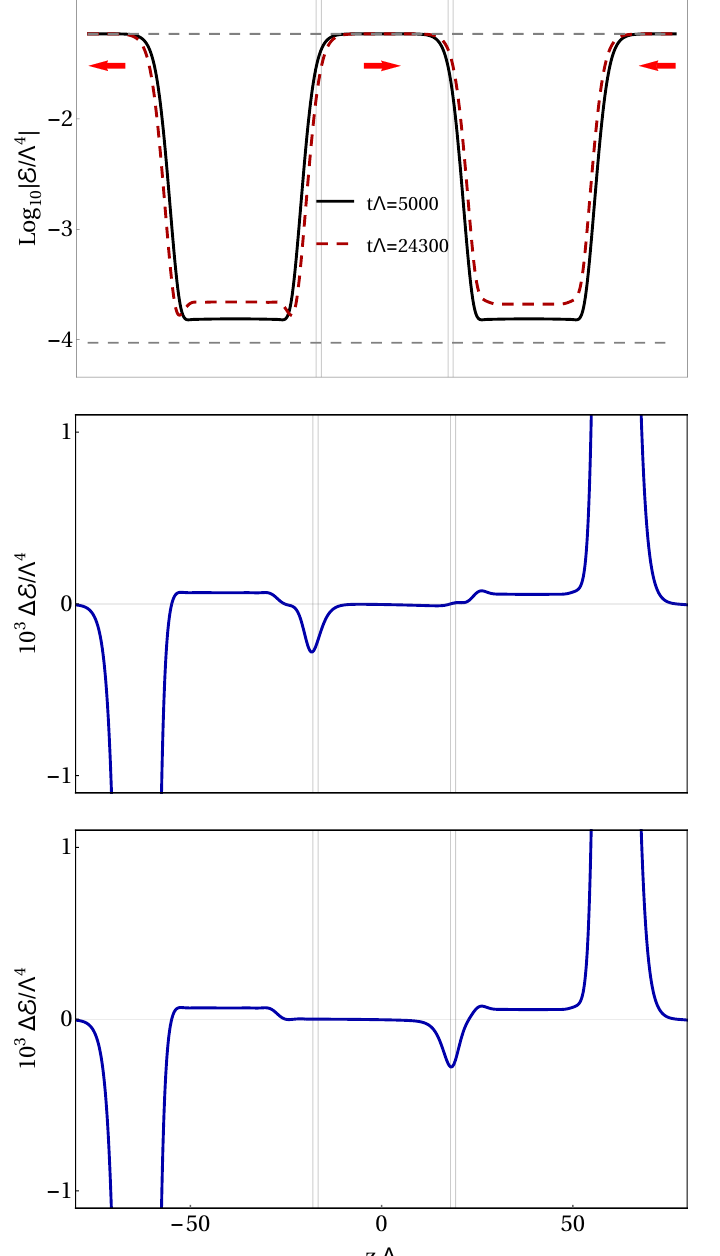
Figure 20 . (Top) Snapshots of the energy density at two very late times for the simulation of (cid:12)gure 16(right). The top and bottom dashed, grey, horizontal lines correspond to E high and E low , respectively. The arrows indicate the direction of motion of each domain. (Middle) Di(cid:11)erence between the energy densities in (top), E ( t (cid:3) = 24300) (cid:0) E ( t (cid:3) = 5000), having shifted the red, dashed curve to the left by an amount (cid:1) z (cid:0) (cid:1) ‘= 2 (see main text). (Bottom) Same di(cid:11)erence between the two energy densities in (top) but now having shifted the red, dashed curve to the left by an amount (cid:1) z + (cid:1) ‘= 2 (see main text). In all three rows the grey, vertical lines indicate the in(cid:13)ection points of the interfaces of the central domain.